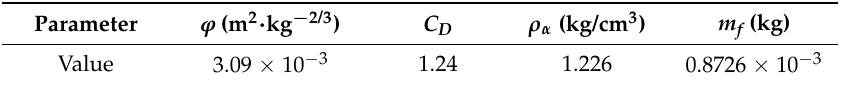
Table 5. Parameter values of the cubic